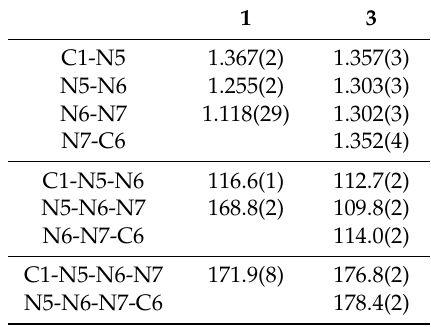
Table 2. Selected bond lengths, angles, and torsions for compounds 1 and 3 (Å, ˝